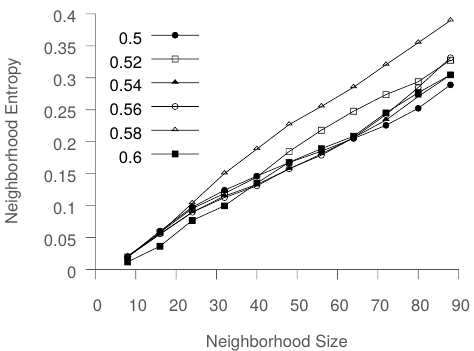
Figure 5. Neighborhood entropy of different trajectories as a function of k ( χ = 3.0 and φ ∈ { 0.50,0.52,0.54,0.56,0.58,0.6 } ). Algorithm 2 outlines the step of the proposed Entropy-Isomap algorithm. While the proposed